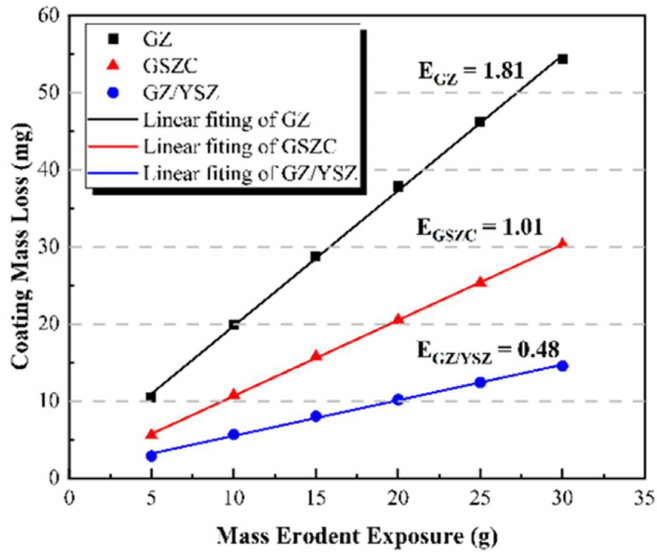
Figure 16. Coating mass loss as a function of erodent exposure for gadolinium zirconate (GZ), gadolinium zirconate and yttria stabilized zirconia (GZ/YSZ), and gadolinium-zirconate-blended feedstock (GSZC) thermal barrier coatings. Reprinted from